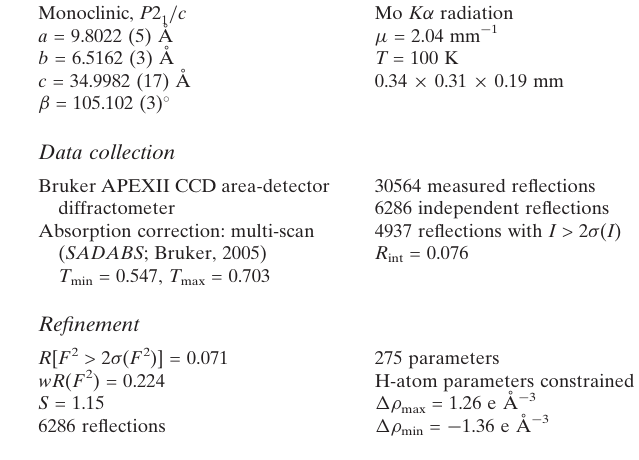
30564 measured reflections 6286 independent reflections